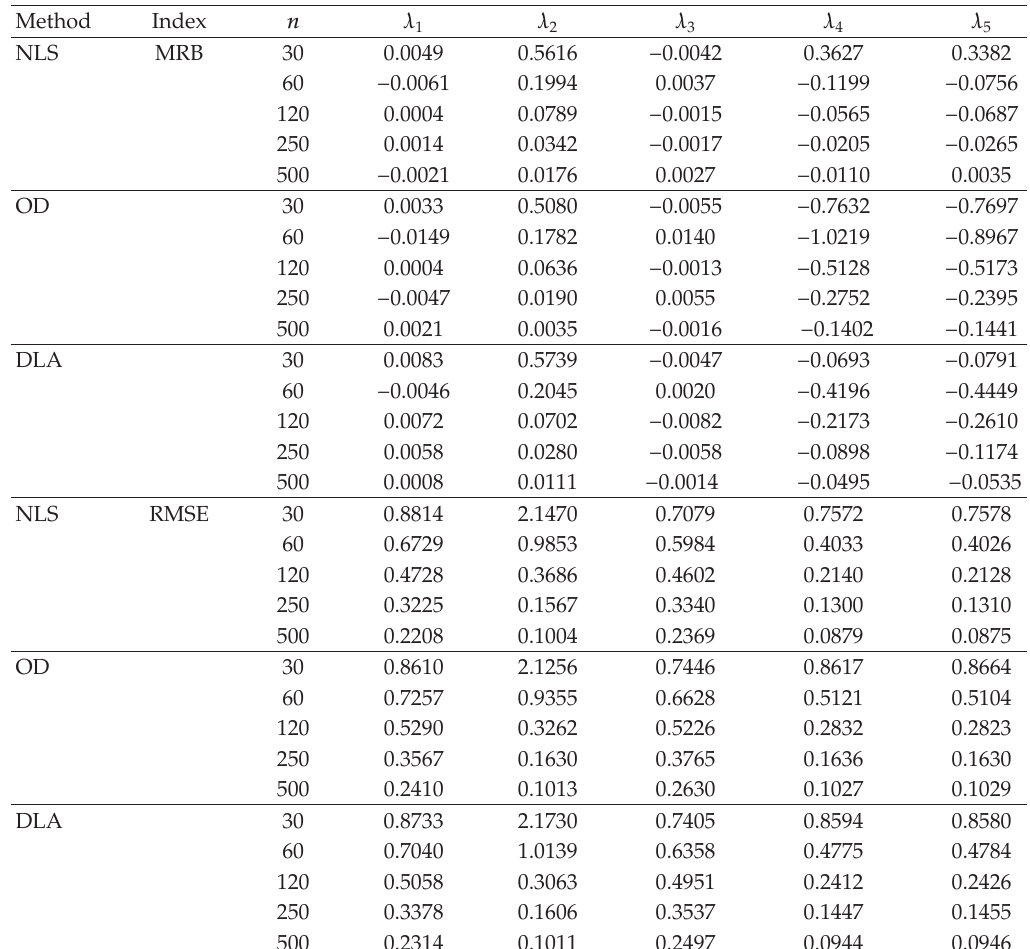
Table 4: Simulation